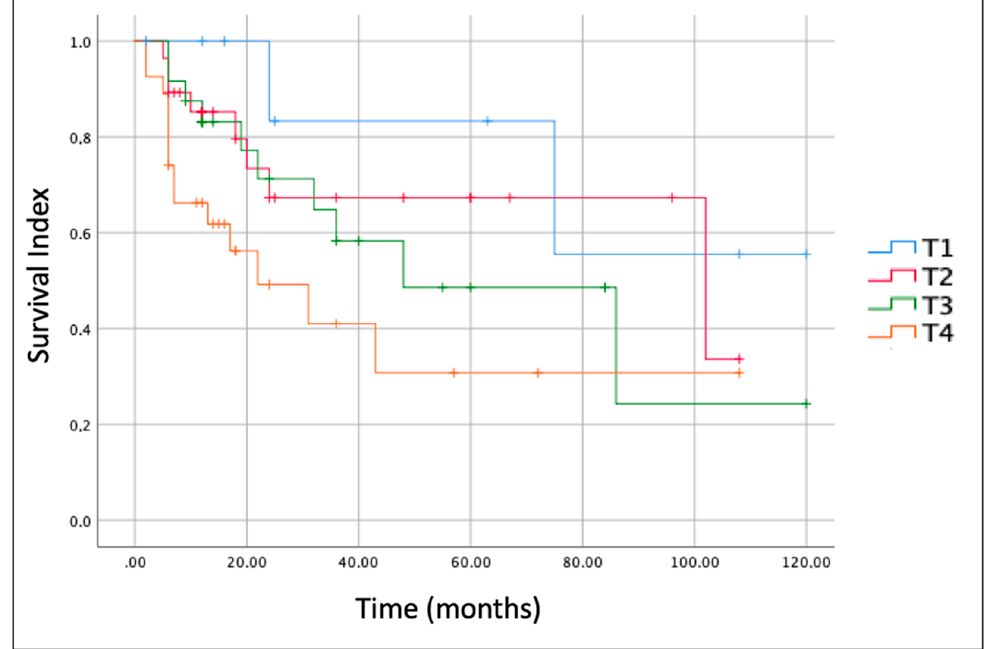
Figure 3. Kaplan-Meier curves and overall survival (OS) of the patients with parotid gland sarcoma included in this study according to the different size/extension (T according to AJCC, [3]) of the tumor.